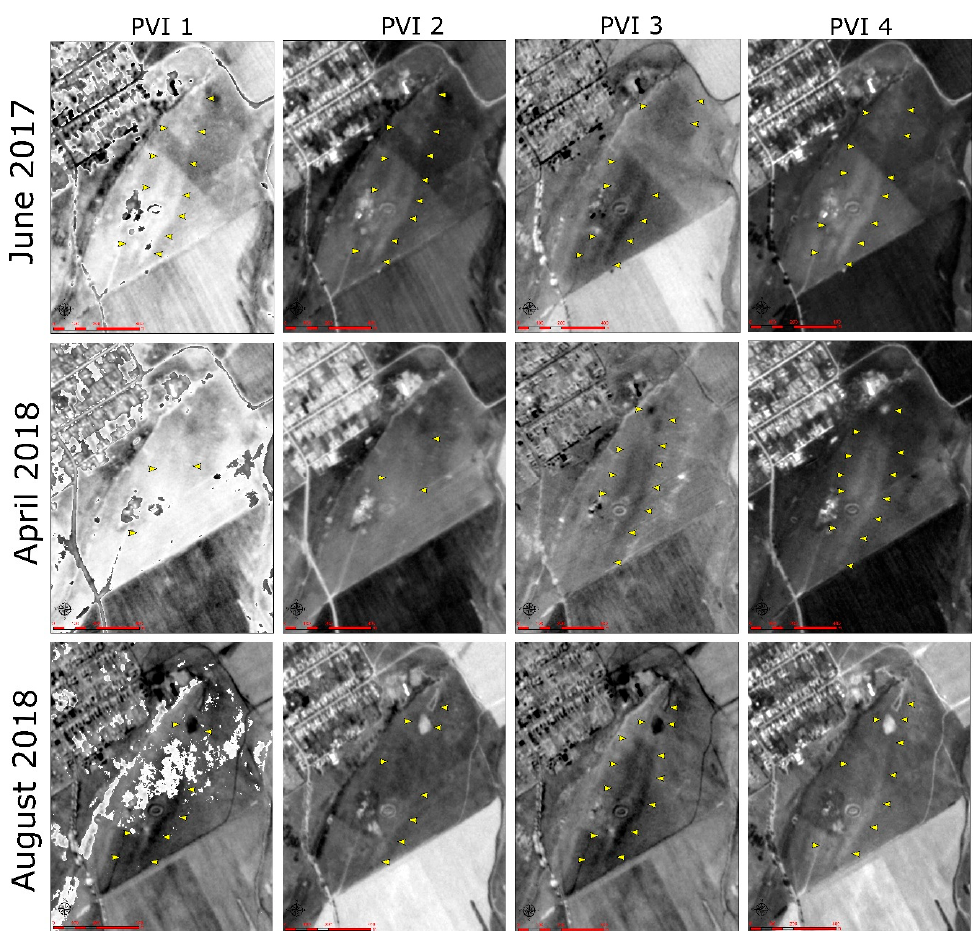
Figure 5. Results of PVI 1, PVI 2, PVI 3 and PVI 4 algorithms for the three different satellite image captures. The yellow arrows indicate the features shown in each image.